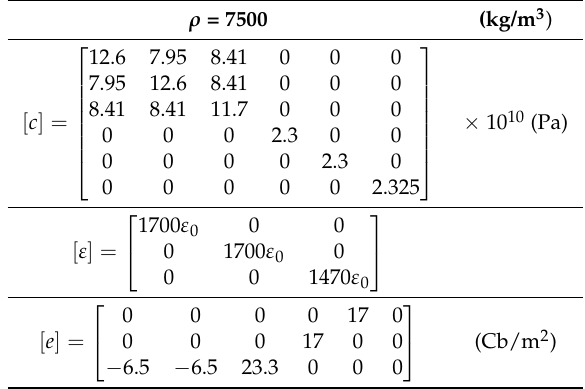
Table 2. Material properties of